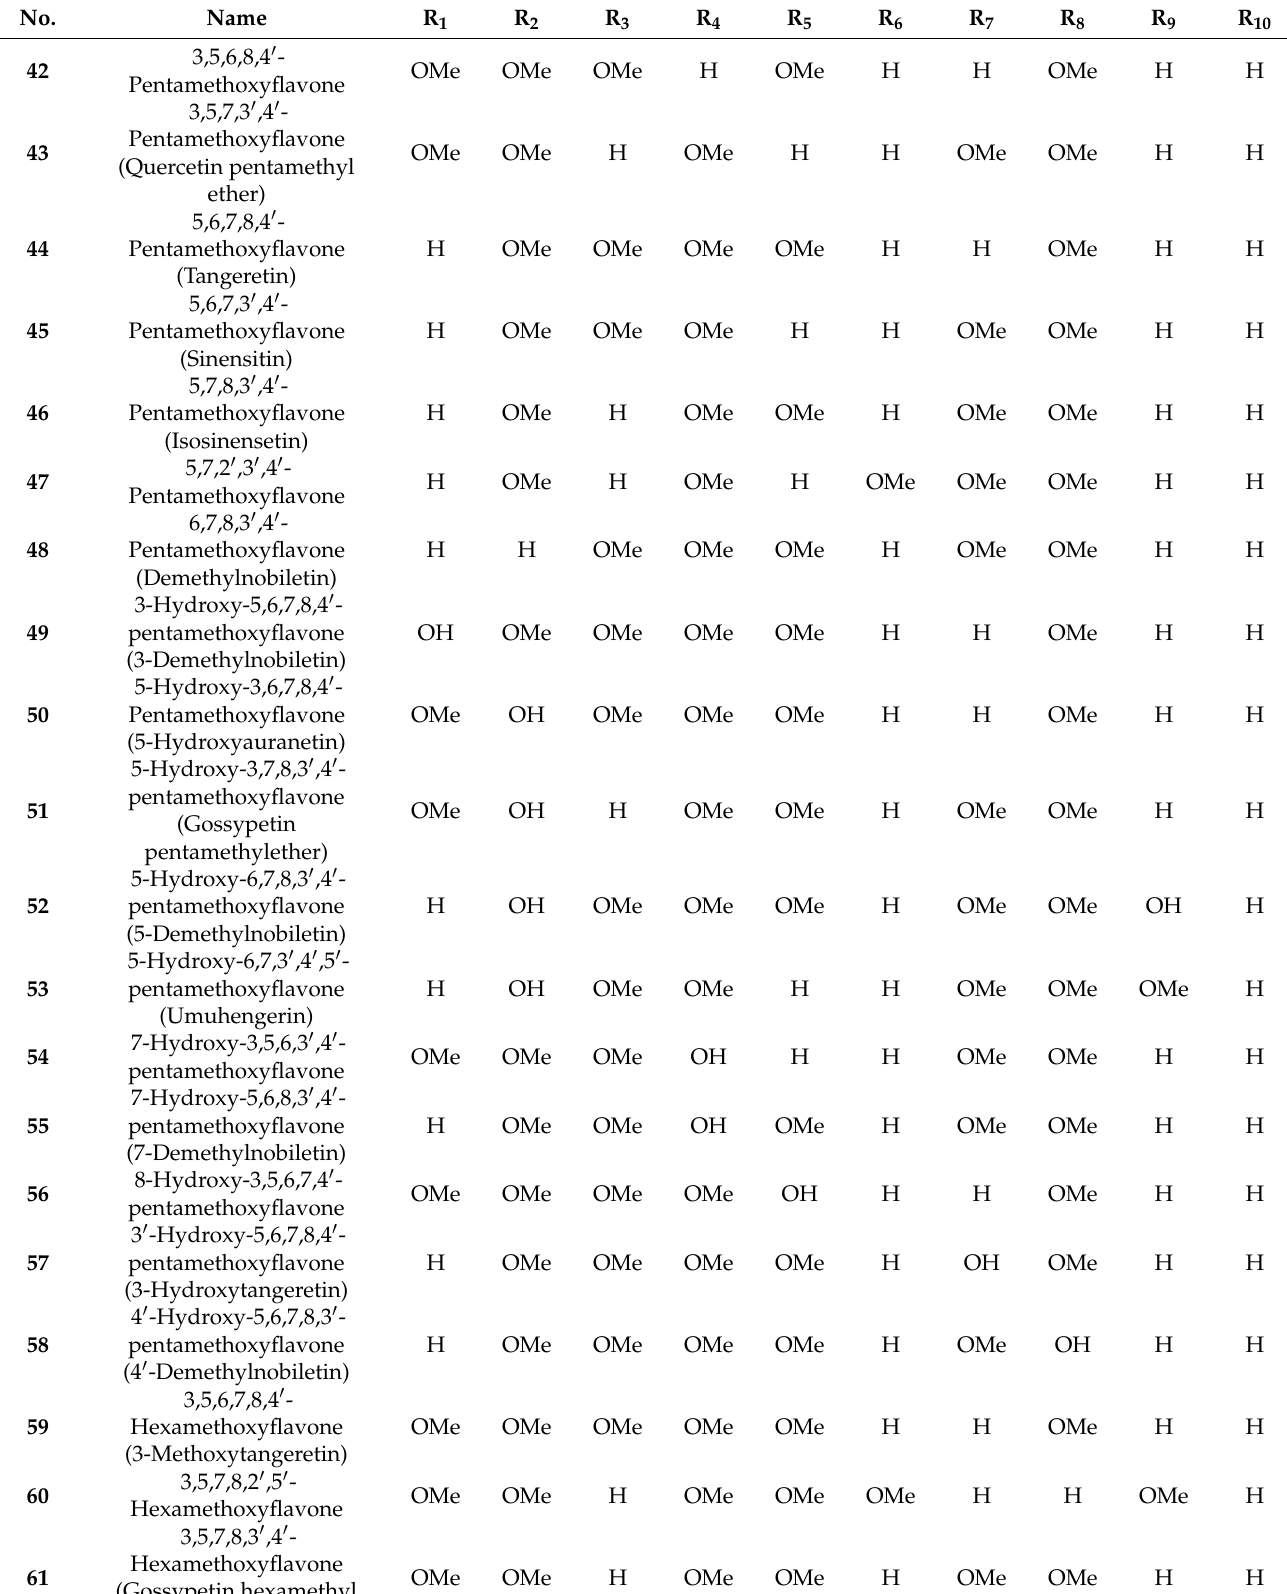
Hexamethoxyflavone (Gossypetin